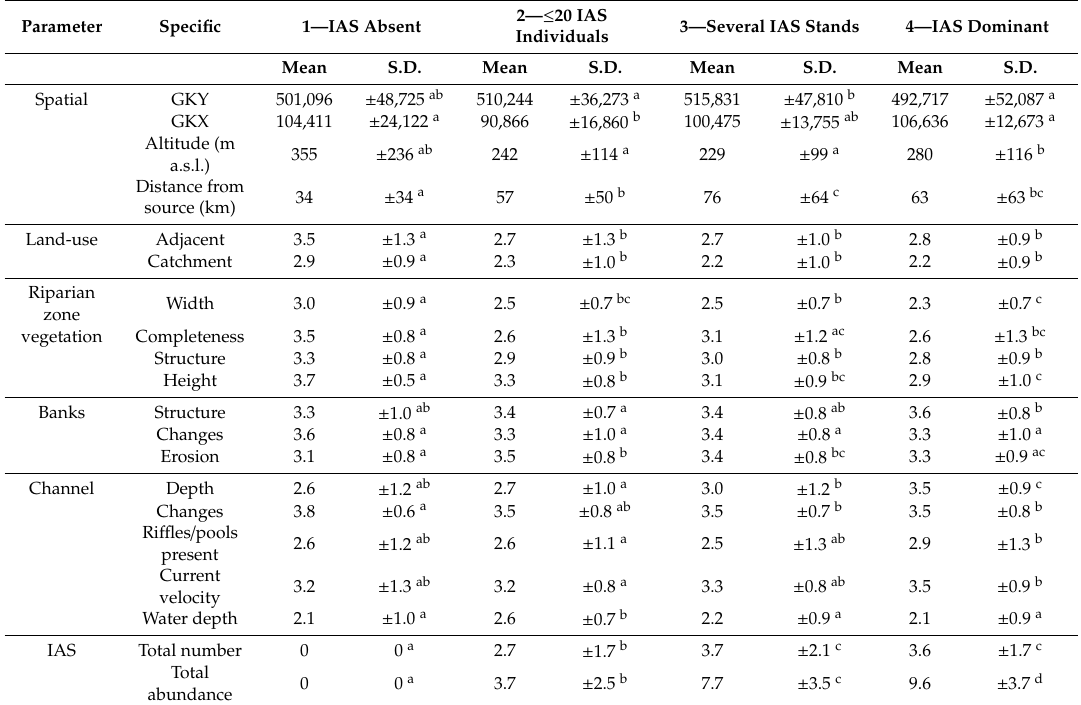
Table 3. Environmental parameters of the river reaches in relation to IAS abundance